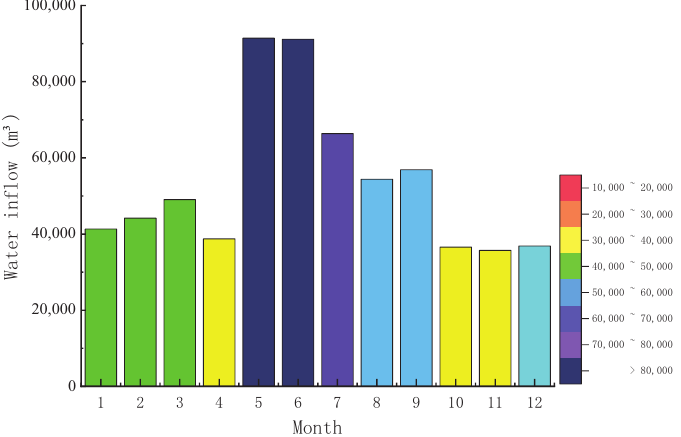
Figure 6. Water inflow in Dahaize coal